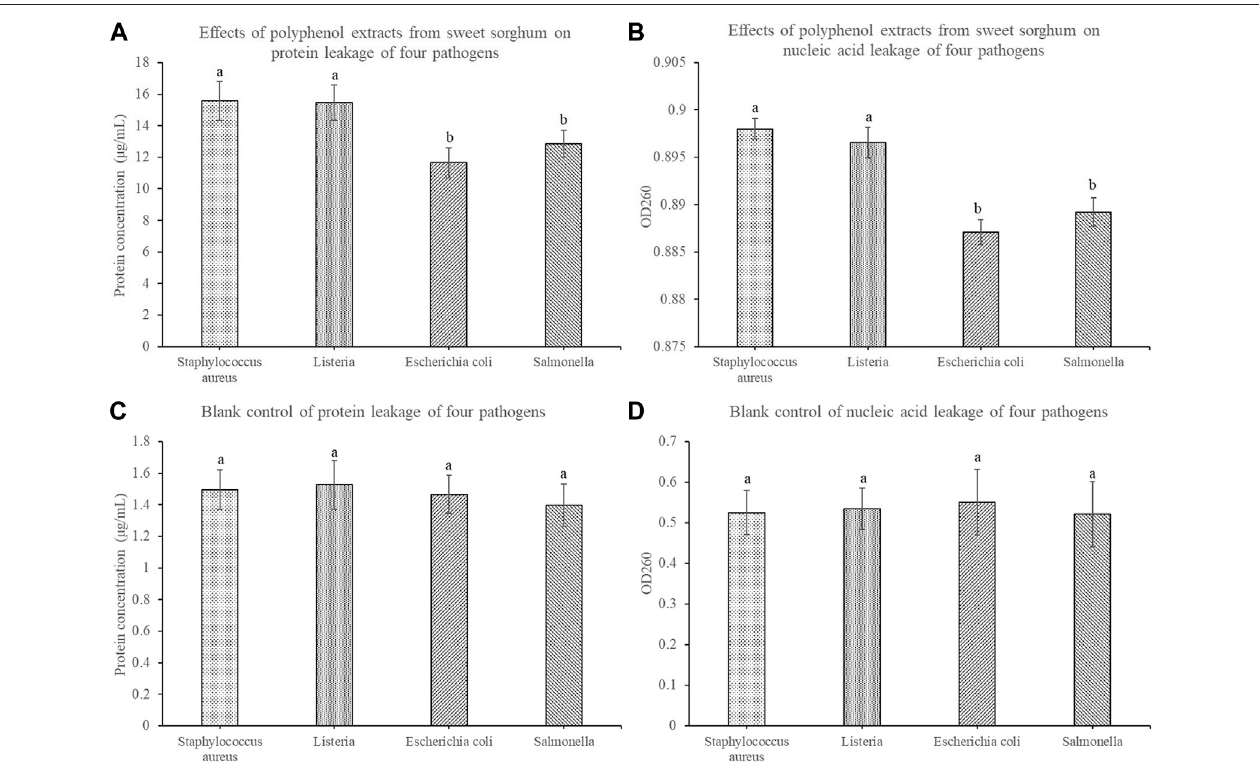
FIGURE 7 | Effects of sweet sorghum polyphenol extract on protein leakage and nucleic acid leakage of four pathogenic bacteria (A) displays data for protein leakage and (B) displays data for nucleic acid leakage (C) and (D) display data of the corresponding blank control groups. The data are expressed as mean ± standard deviation. One-way ANOVA ( p < 0.001) and Dunnett ’ s posttest were used for statistical analysis. Different lowercase letters in the fi gure indicate differences in signi fi